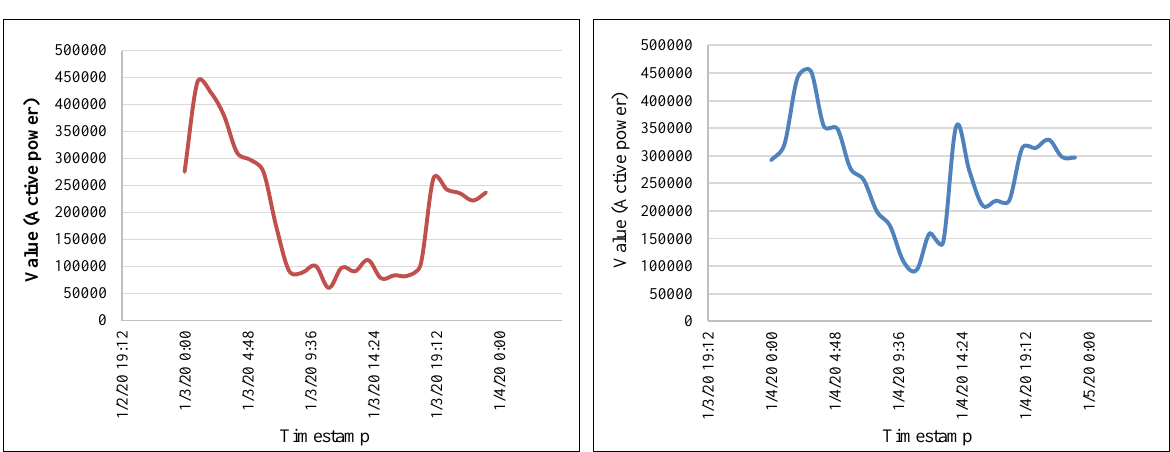
Figure 4. 24-hour Energy Consumption Time-series Data Plotted.